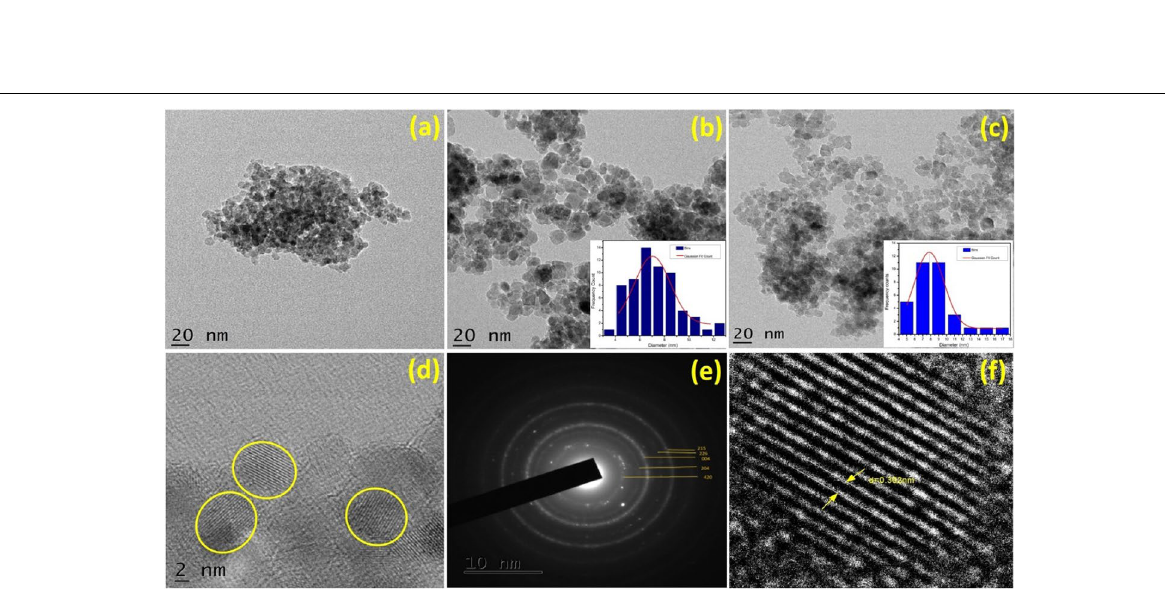
Fig. 4 TEM micrograph of a UTO, b ZMT4, c ZMT4S2, d HRTEM image of ZMT4S2, e SAED pattern and f lattice fringes of